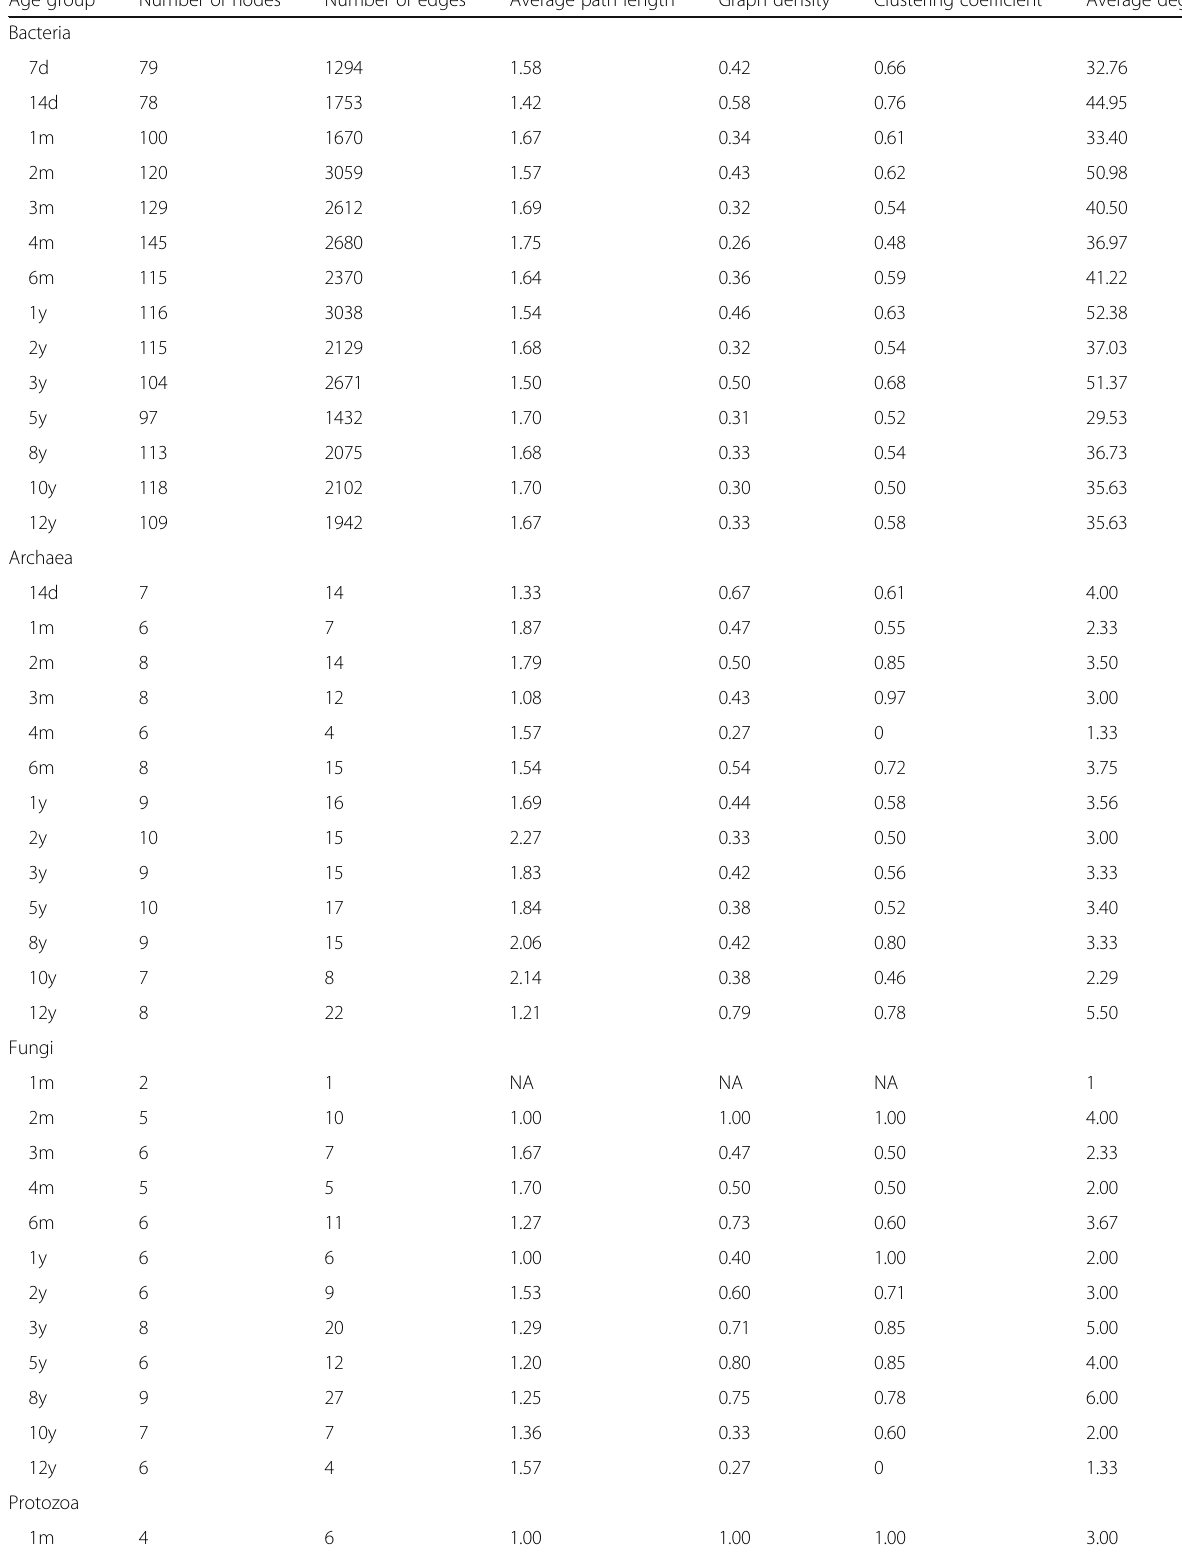
Table 2 Global topological properties of co-occurring networks of intra-interactions in each microbial kingdom Age group Number of nodes Number of